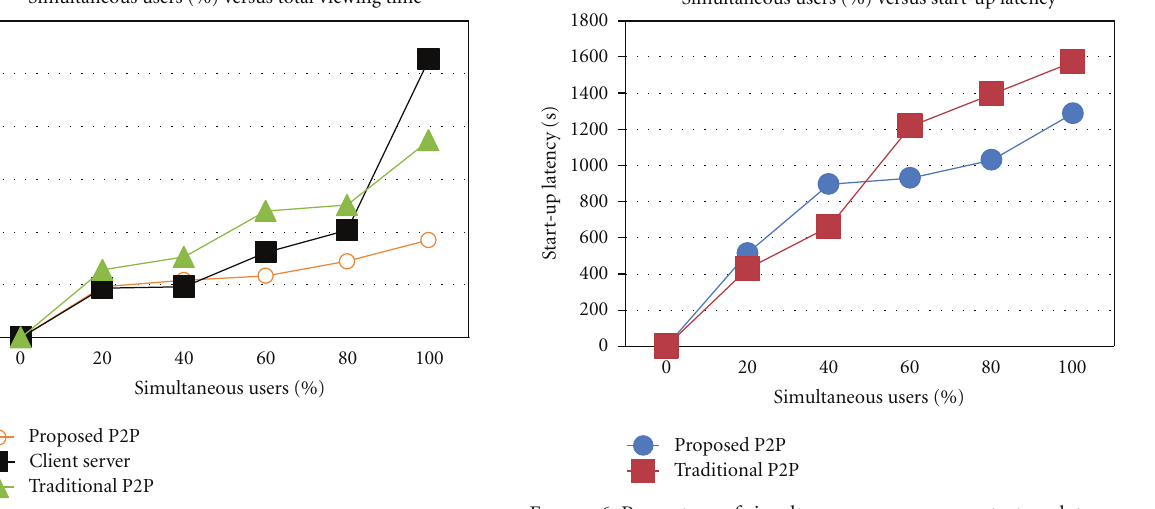
Figure 5: Percentage of simultaneous users versus total viewing time.